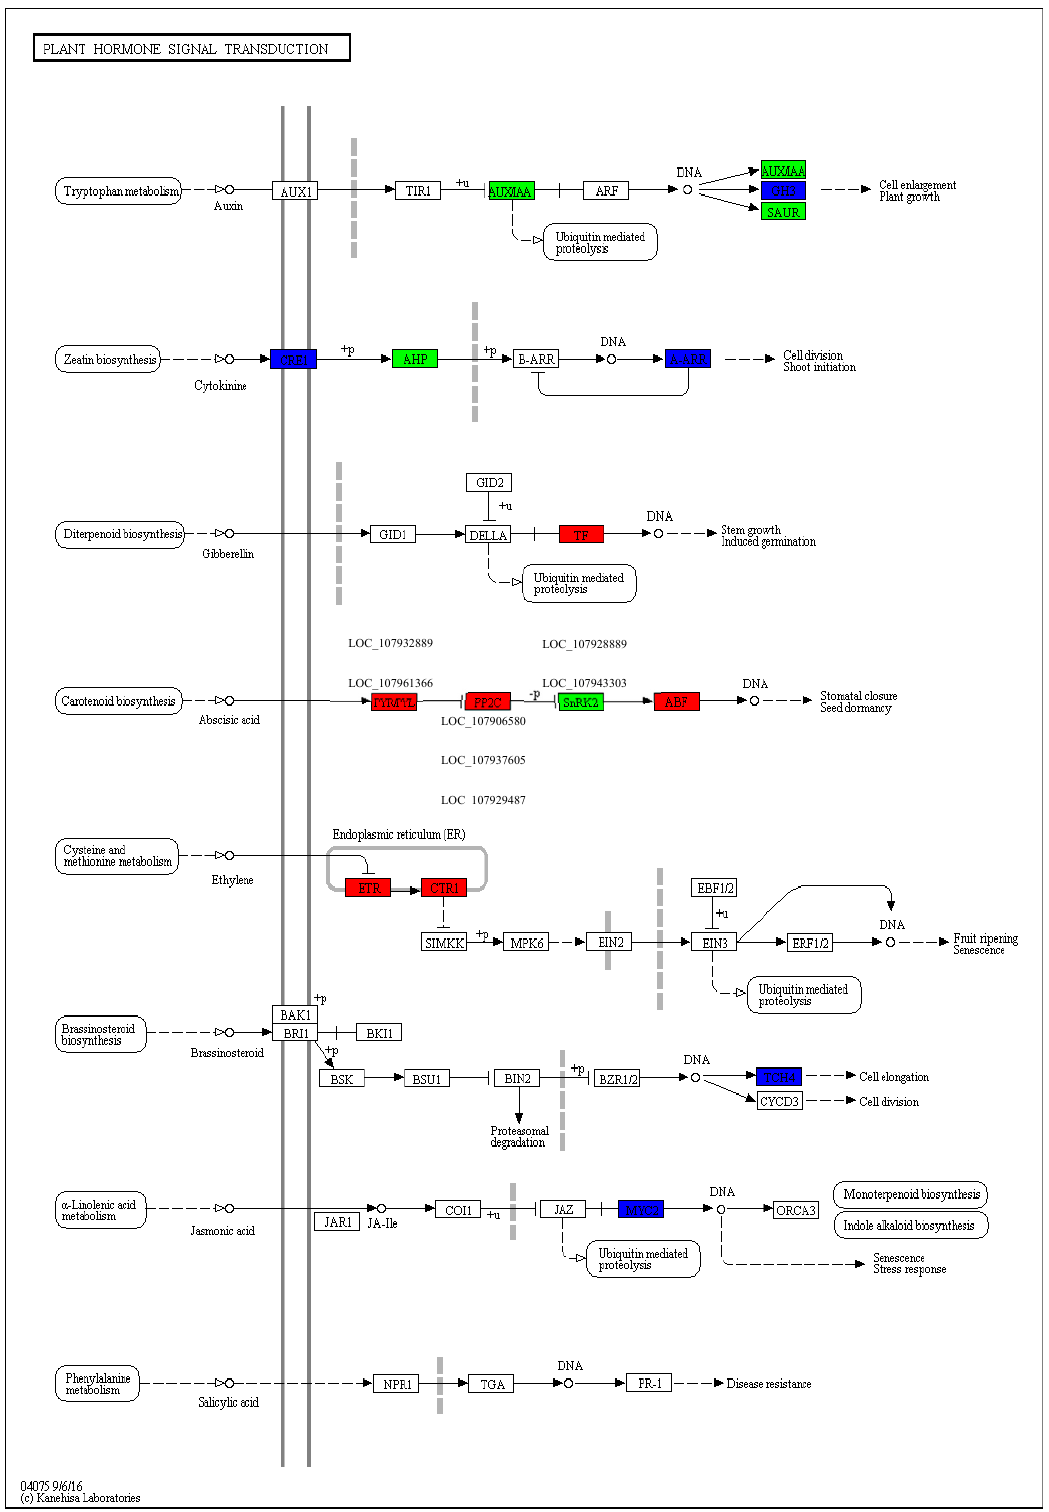
Figure 7. KEGG pathway image of plant hormonal signal transduction DEGs. KEGG search and color pathway analysis of significant differentially expressed transcripts in plant hormonal signal transduction pathway in TM-1 cotton species leaf under drought stress. Enzymes coded red are up-regulated and blue are down-regulated, and purple genes denote the reference pathway.